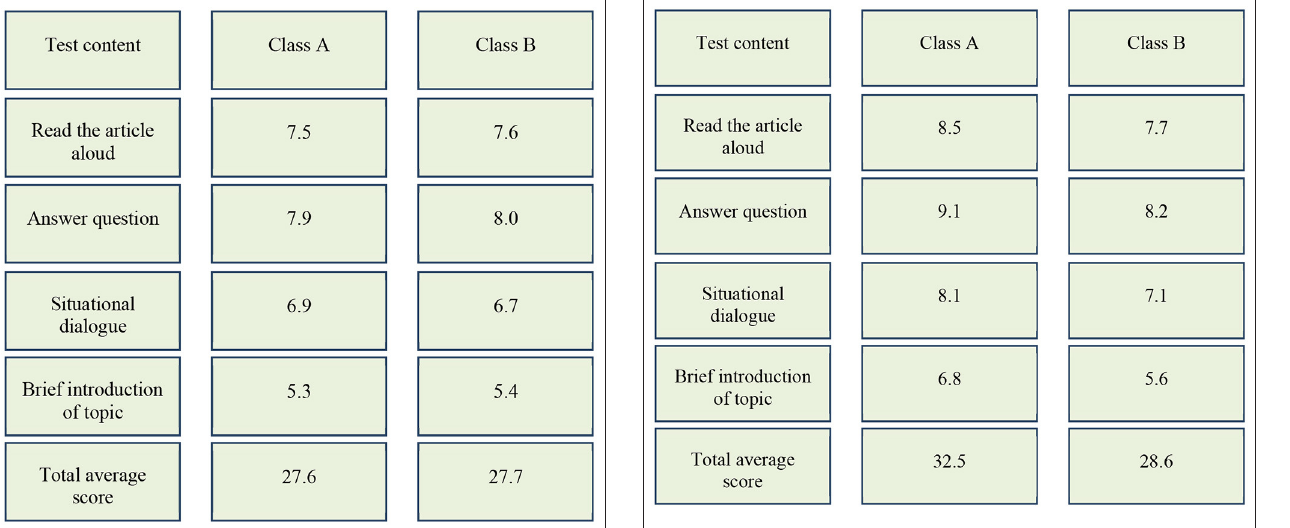
FIGURE 7 | Comparison of post-test scores of students in classes A and